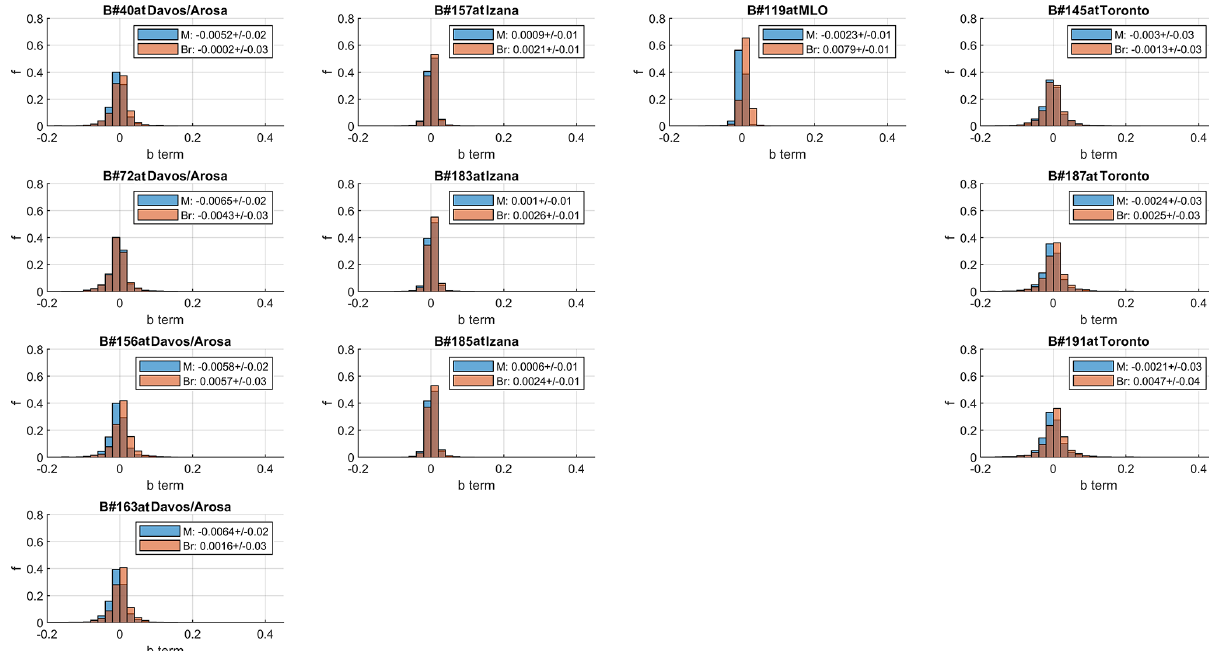
Figure A5. Histograms of second-order polynomial fitting coefficient (first-order term; linear term) for daily ozone. The values indicated in the legends are the mean ± 1 σ of the coefficients.